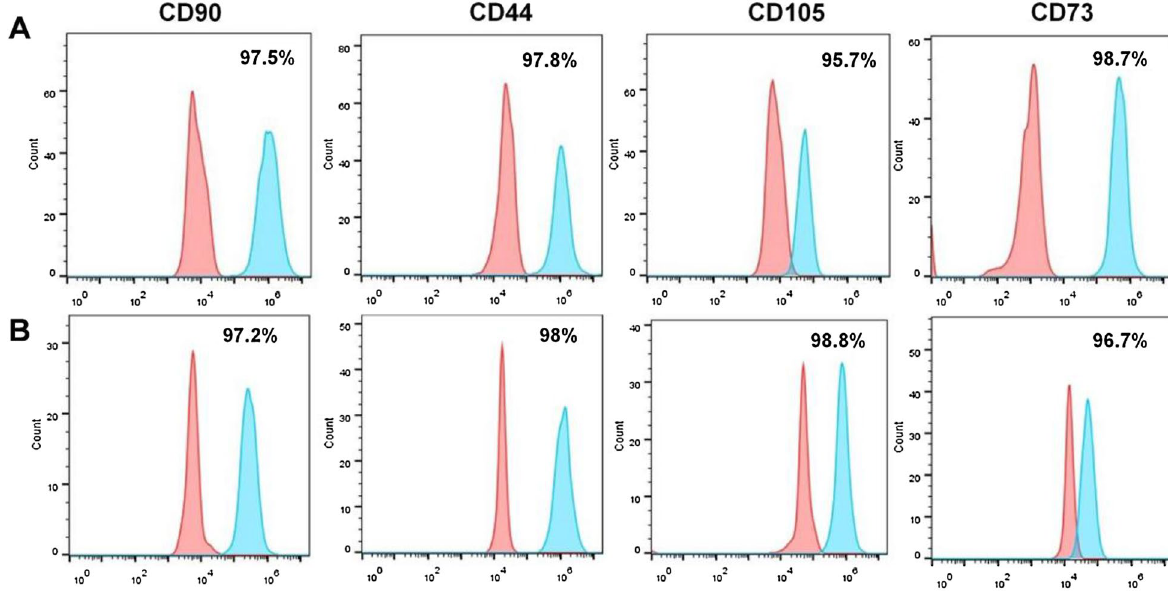
Fig. 5 Specific hUC-MSCs markers were identified by flow cytometry. A Markers (CD90, CD44, CD105, and CD73) of the released hUC-MSCs from the PLGA@PLL scaffold. B The native MSCs from Wharton’s jelly served as